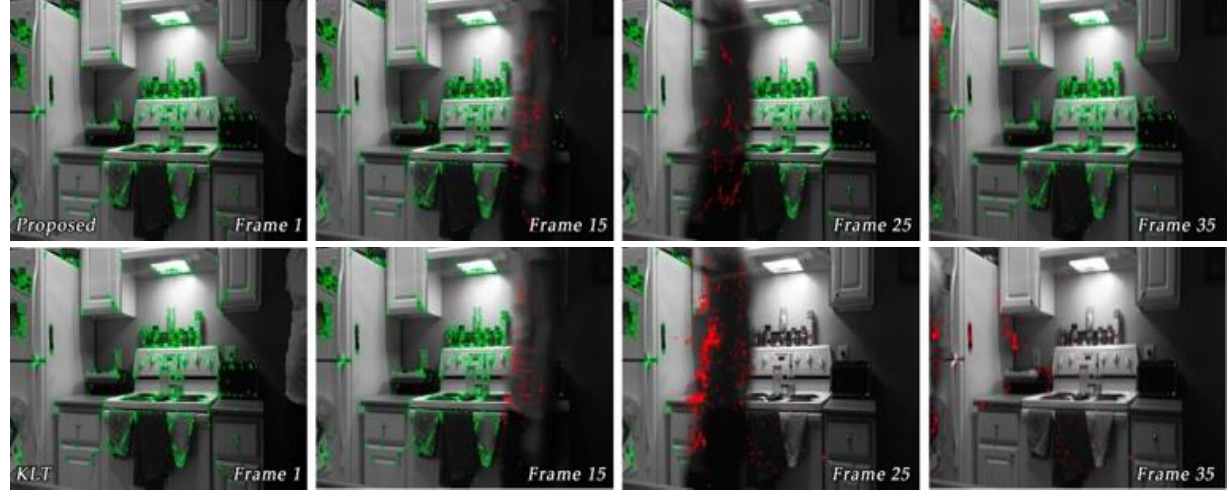
Figure 4. Tracking comparison between the proposed method (top) and KLT (bottom) shows a significant tracking improvement when occlusion is